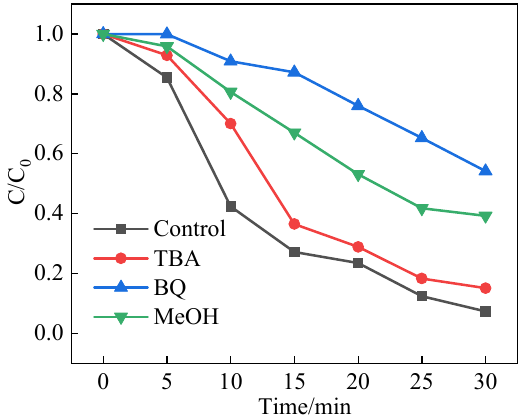
Figure 9. Effect of scavengers on BPA removal in the LCFO/PMS process. Conditions: C 0 = 0.05 mM, [LCFO-4] = 0.7 g/L, [PMS] = 10.0 mM, [Scavenger] = 50 mM.